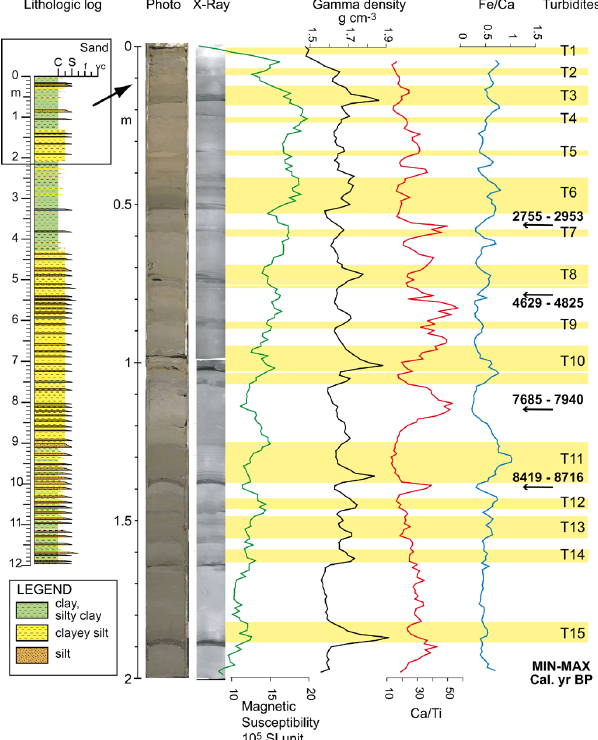
Fig. 6. Lithologic log of sediment core PSM-KS23 from the distal area of the Algiers turbiditic system in 2775m water depth. Note the contrast between the closely spaced thin turbidites at the base of the core and the more widely spaced turbidites in the upper part. On the right: detail of the 2 upper meters of the core. The identifi- cation of turbidites is based on the comparison of photo and X-ray images of the sediment core, magnetic susceptibility, gamma den- sity and XRF elemental ratios Ca/Ti (proxy for carbonate produc- tion, with high values in hemipelagic intervals), and Fe/Ca (detri- tal proxy, with high values in the turbidites). The radiocarbon ages show that during the Holocene the time interval between two adja- cent turbidites is in the order of about 800